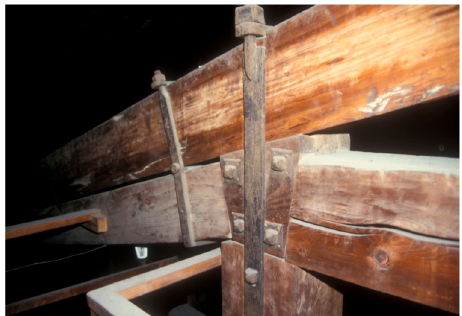
Figure 9. Salone dei Cinquecento , Palazzo Vecchio , Florence, Italy: Detail of timber roof structure and iron